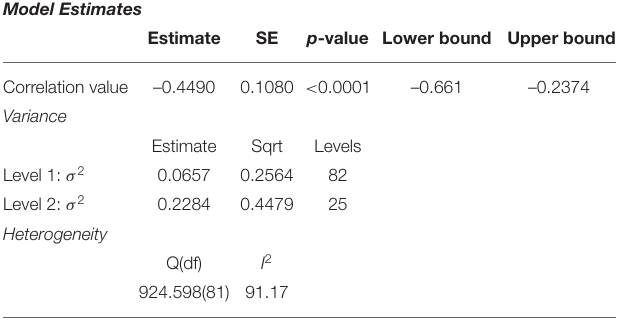
TABLE 4 | Model 3: Exploratory Meta-correlation results with executive function/process studies